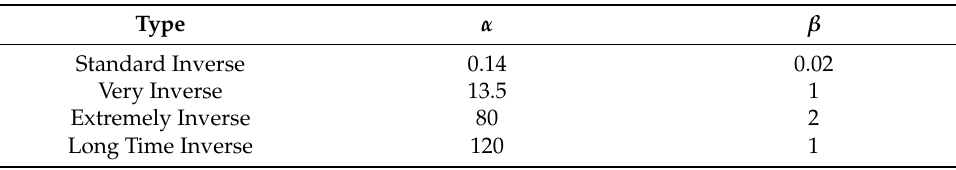
Table 1. Relay characteristics